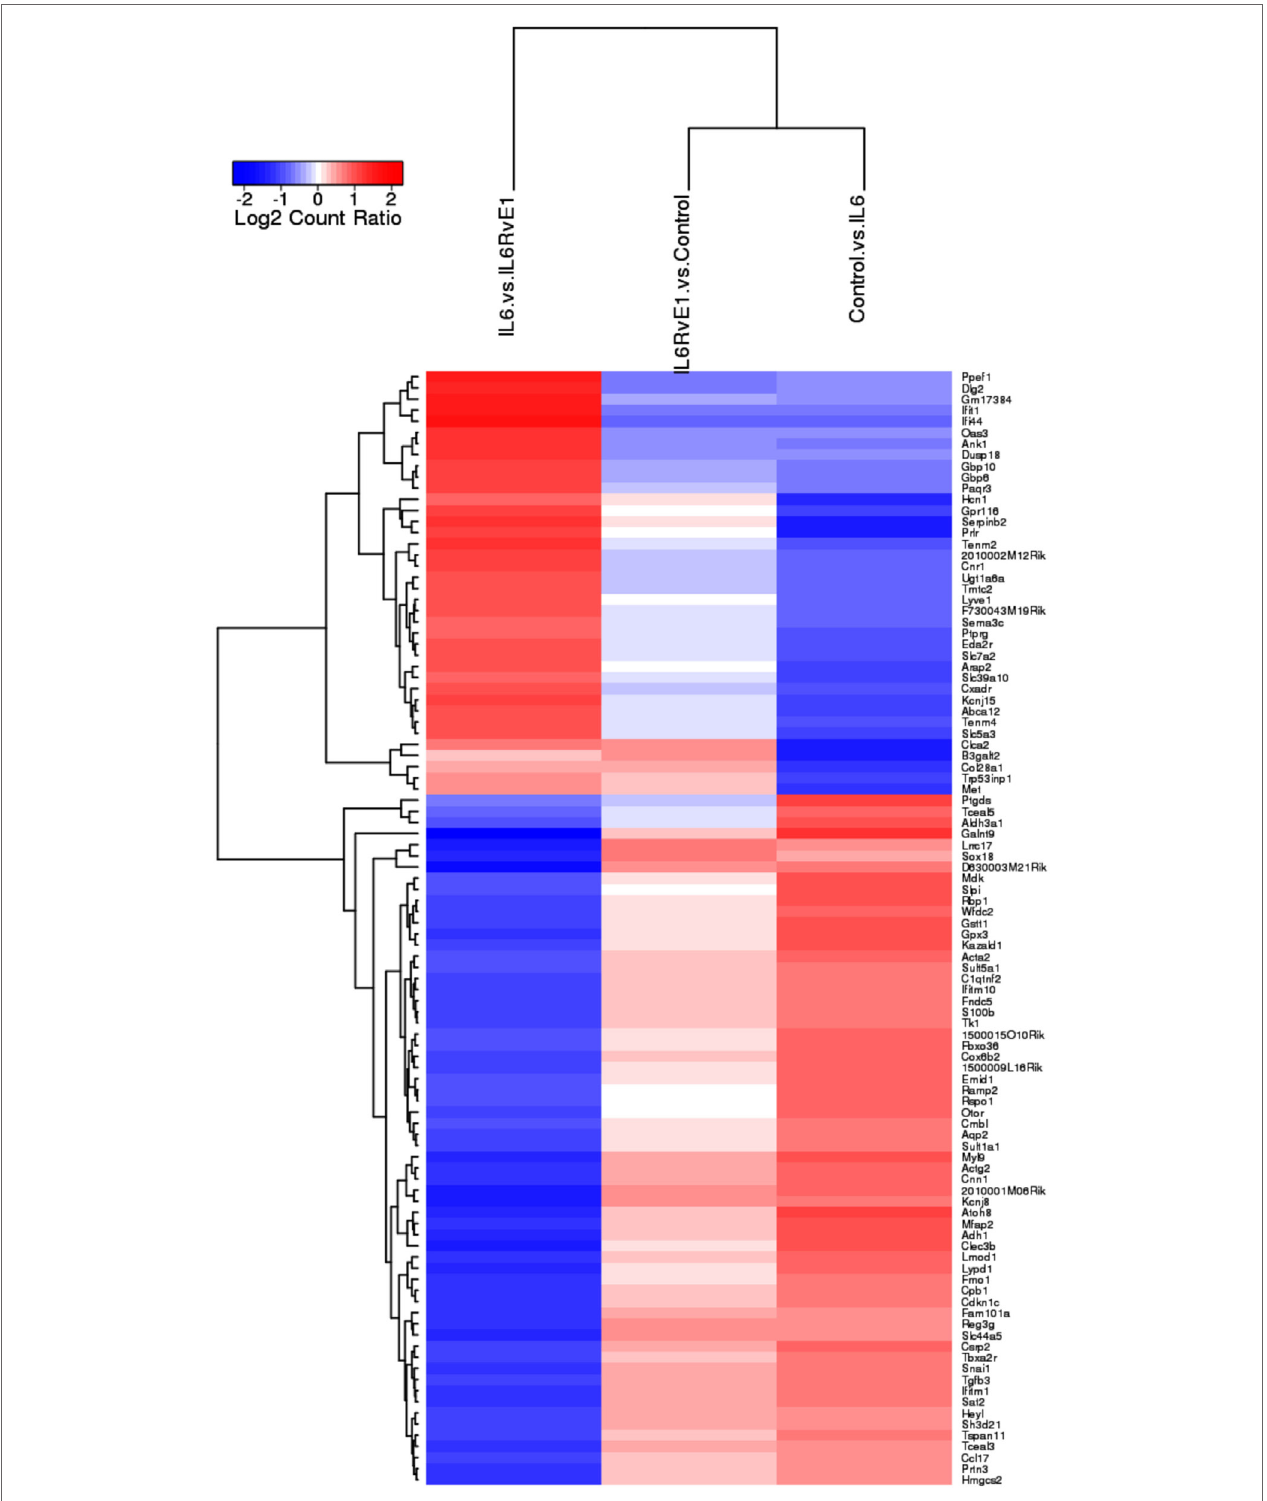
FigUre 3 | Gene expression shift with resolvin E1 (RvE1) treatment. A heat map of top 100 differentially expressed genes (absolute log 2 fold change) compares OB + interleukin (IL)-6 vs. OB alone, OB + IL-6 + RvE1 vs. OB alone, and OB + IL-6 + RvE1 vs. cells + IL-6. The color intensity reflects the level of log 2 fold change for each comparison with red for upregulation and blue for downregulation. Fainter colors indicate lesser changes in gene expression between the groups being compared. Genes were ordered based on a dendrogram derived from hierarchical clustering of log 2 values of all rows; genes with similar differential expression patterns were grouped together. The result demonstrates a remarkable mirror image change in gene expression. Results are expressed as mean of genes highly expressed.